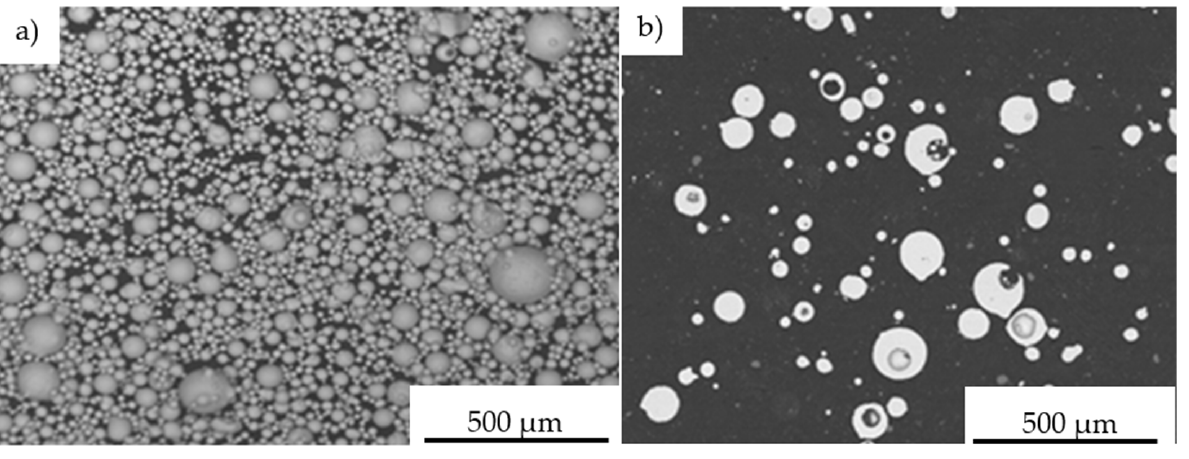
Figure 9. Analysis of the particle diameter distribution of the Fe40Al at.% (VIGA) powder using an IPS UA analyzer in as-received state: volumetric fraction ( a ), fraction of particles in specific size classes ( b ).